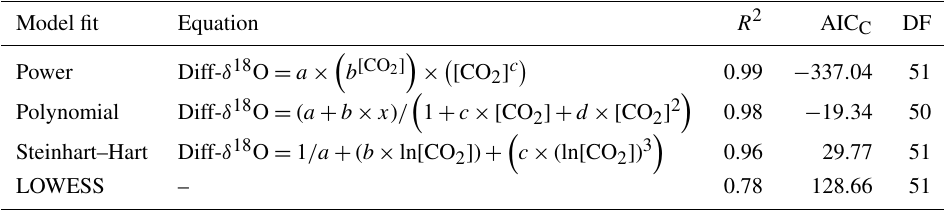
Table 2. Correction factor models are fitted for Diff- δ 18 O, DF (degrees of freedom), AIC C (Akaike information criterion), and [CO 2 ] CO 2 concentration in ppm.